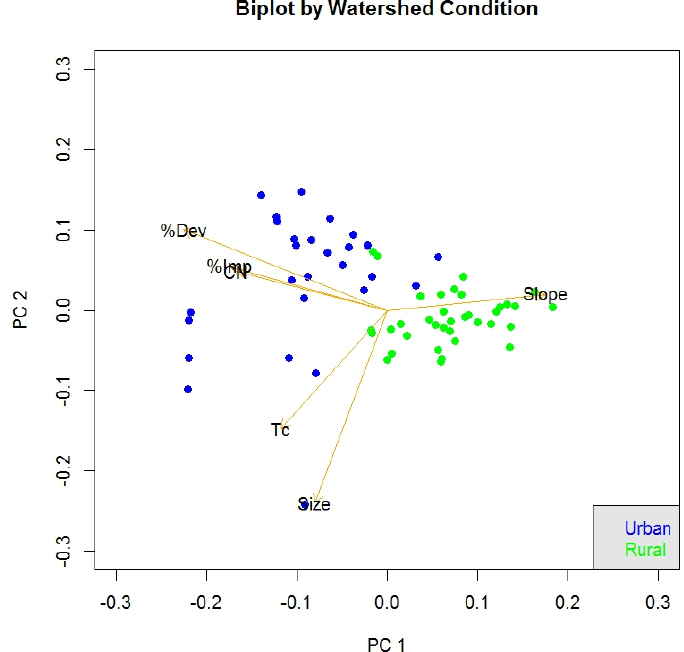
Figure 4. Biplot of the first two principal components for watershed conditions with stream symbols coded by urban compared with rural classification (n = 65 streams).